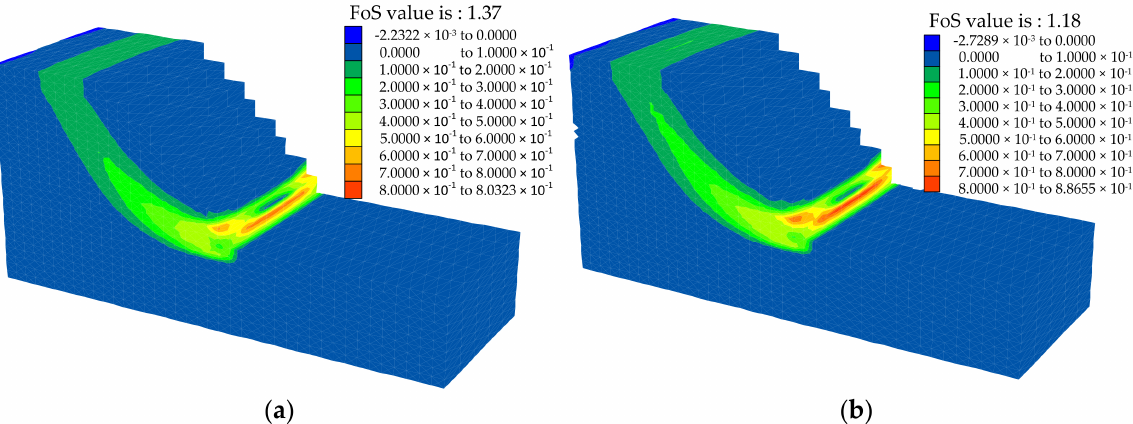
Figure 13. Calculation results of long-term aging slope stability. ( a ) Before parameter attenuation; ( b ) after parameter attenuation.